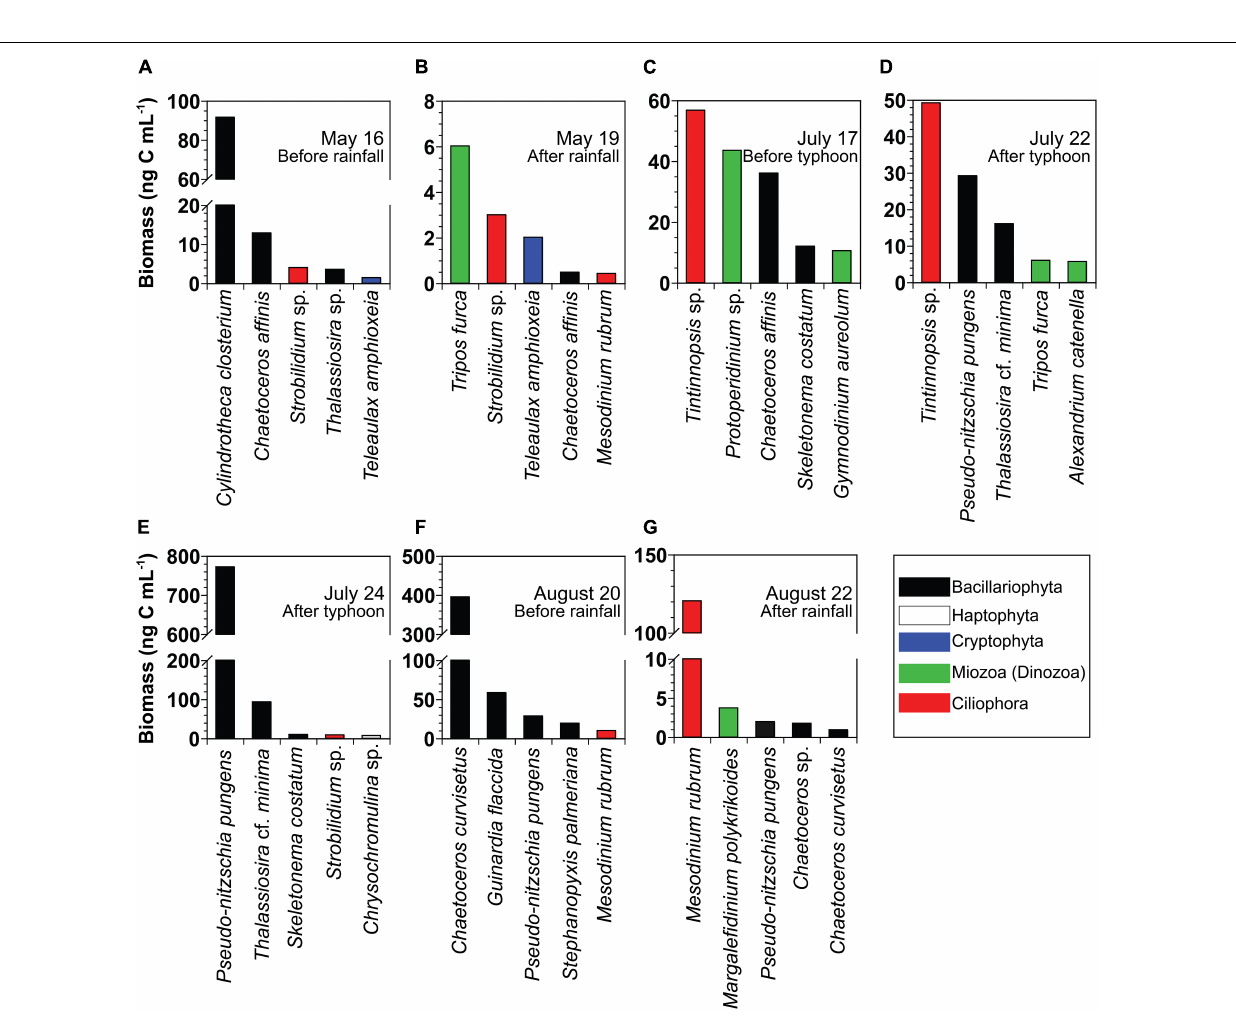
FIGURE 3 | (A–G) Biomass of the five dominant planktonic protists at the beginning of the incubation of the seven different seawater samples collected from St. Gyedong (August 22) or St. Gukdong (the remaining dates) in 2019. To convert the unit from cell abundance to biomass, the cellular carbon content of each dominant species was obtained from Goldman (1993), Olenina et al. (2006), Yoo et al. (2010); Lee et al. (2014), Harrison et al. (2015), and Lim et al. (2019). The cellular carbon content of Alexandrium catenella was calculated from the equivalent spherical diameter in Kang et al. (2018). The cellular carbon contents of Chrysochromulina sp. (0.004 ng C cell − 1 ), Chaetoceros sp. (0.001 ng C cell − 1 ), Thalassiosira cf. minima (0.02 ng C cell − 1 ), Thalassiosira sp. (0.10 ng C cell − 1 ), Protoperidinium sp. (1.81 ng C cell − 1 ), Strobilidium sp. (1.00 ng C cell − 1 ), and Tintinnopsis sp. (3.78 ng C cell − 1 ) were calculated from the biovolume in this